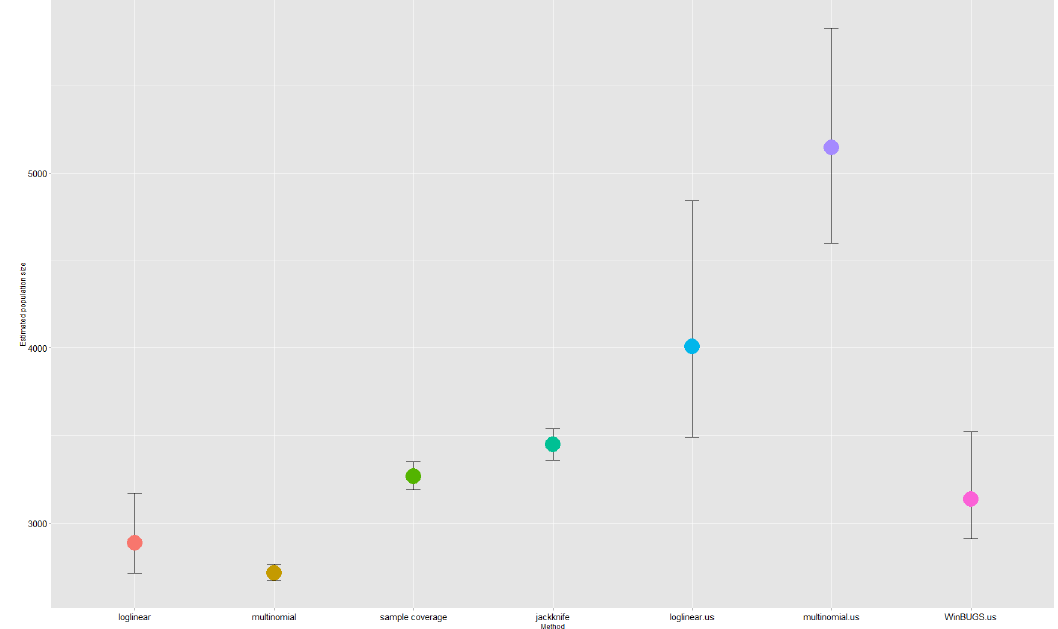
Fig 9. Overview of the seven different estimators for the pertussis study and their 95% confidence intervals.